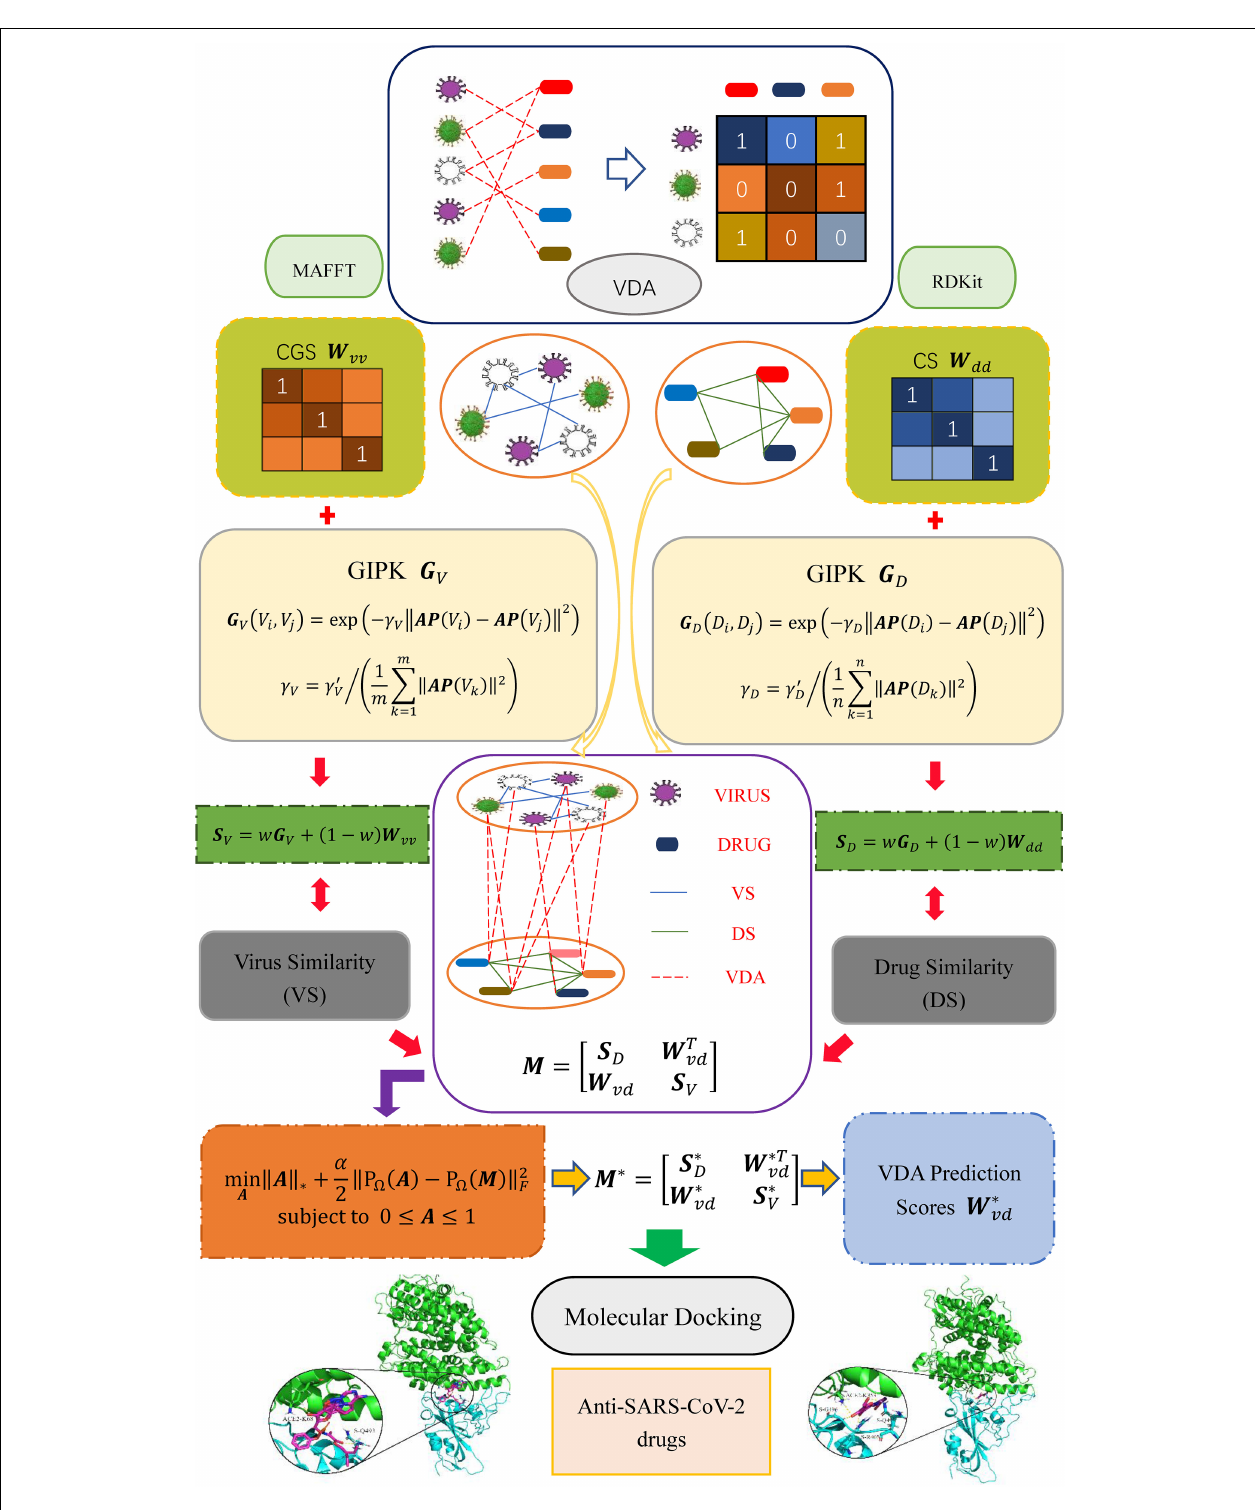
FIGURE 1 | Overall flow chart of